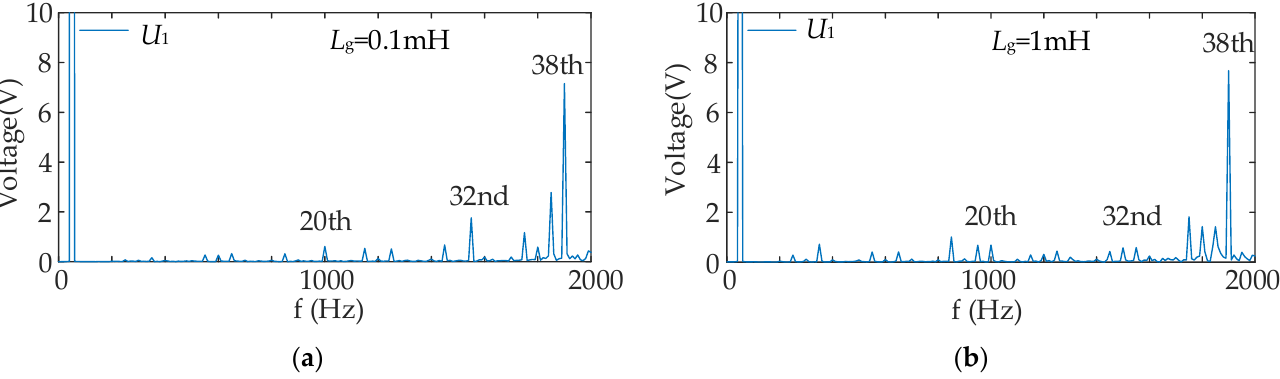
Figure 16. The node voltage spectrum when L g is varied: ( a ) L g = 0.1 mH; ( b ) L g = 1 mH. From the spectrum analysis results, it can be seen that when the grid impedance in- creases, the resonant frequency and harmonic content of the high-frequency part remain unchanged, the resonant frequency of the low-frequency part shifts to the lower part, and the harmonic content at resonance decreases, which is consistent with the results of the modal analysis as well as the frequency domain analysis. Then, the relationship between the variation of the inverter-side inductor L 1 and the resonant characteristics of the system is further verified. In the simulation scenario with two inverters grid-connected, the 22nd, 26th, 38 th , and 40th harmonic test currents are in- jected into the system at L 1 = 0.8 mH and 1.6 mH, and the corresponding inverter node voltage spectrum changes are shown in Figures 17a,b.